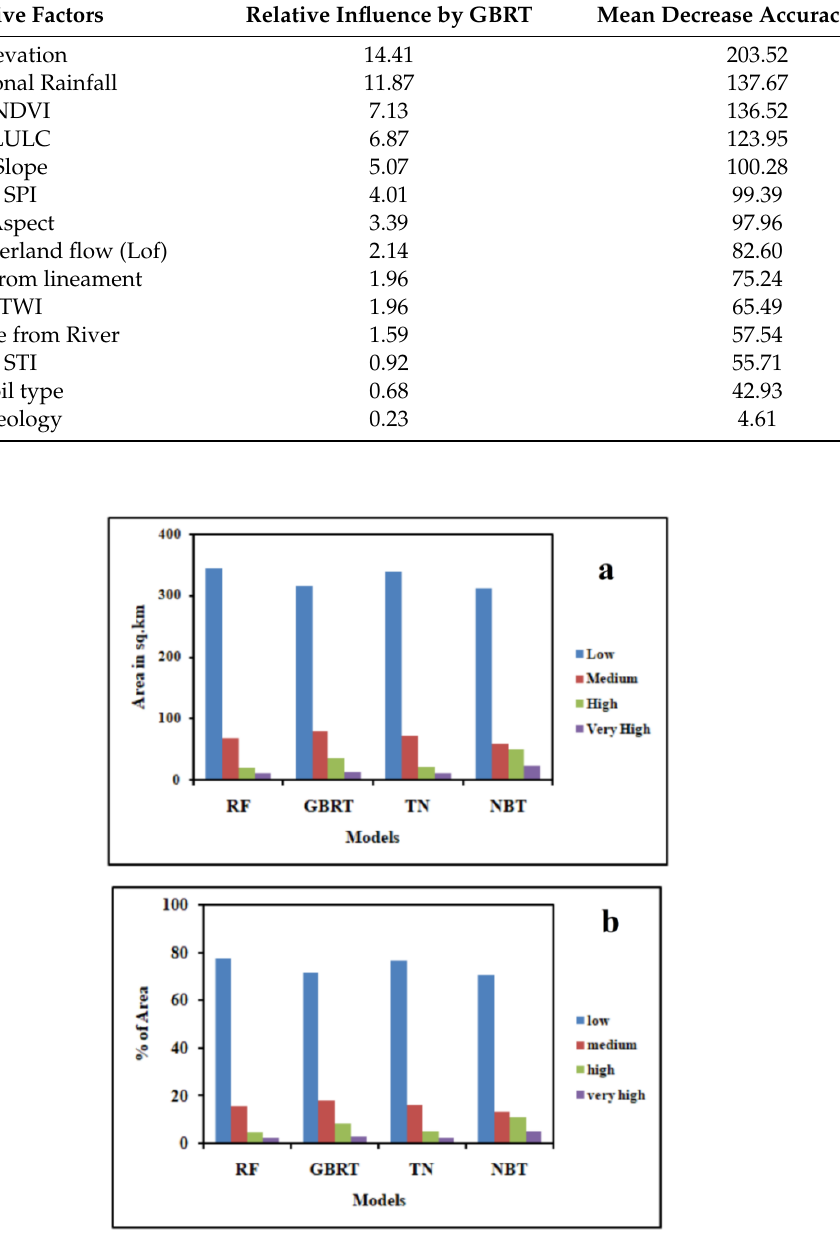
Figure 8. Graphs showing ( a ) areal distribution of RF, NBT, GBRT, and TE models, ( b ) distribution of the percentage of area of RF, NBT, GBRT, and TE models. Table 4. Seed cell area index (SCAI) values of RF, NBT, GBRT, and TE models.